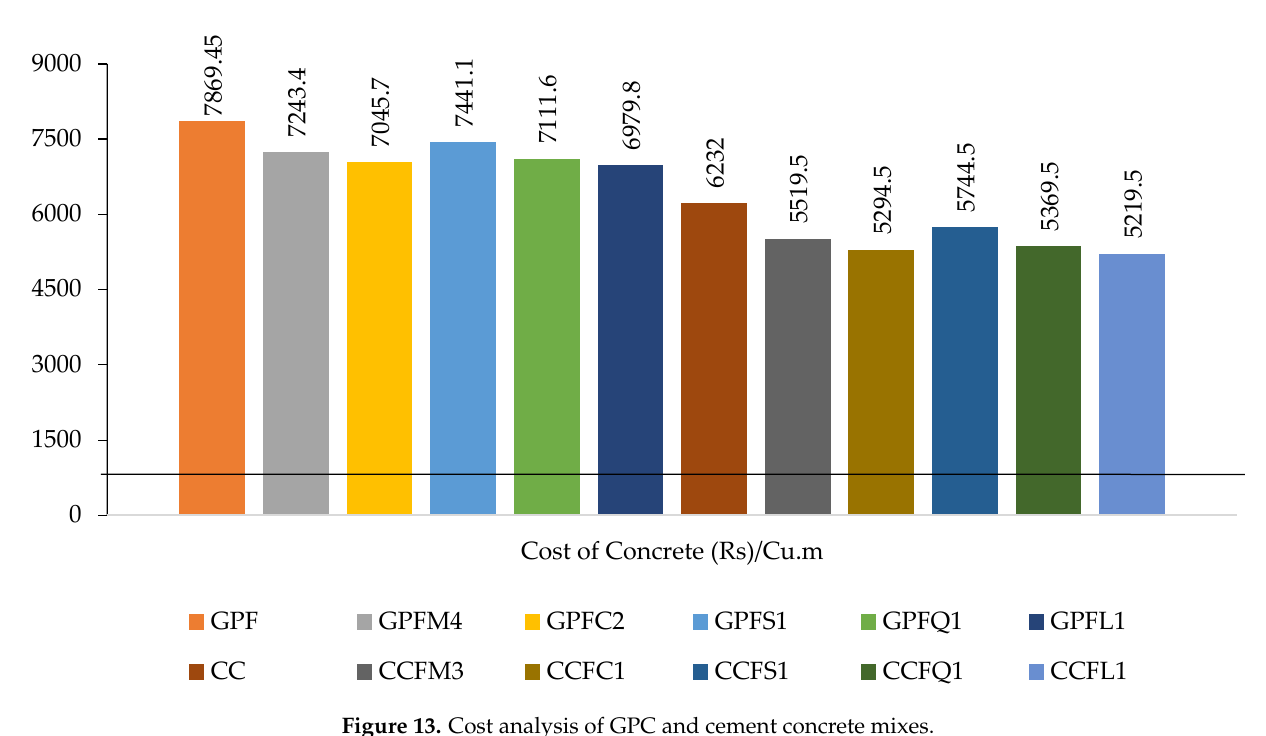
Figure 13. Cost analysis of GPC and cement concrete mixes.